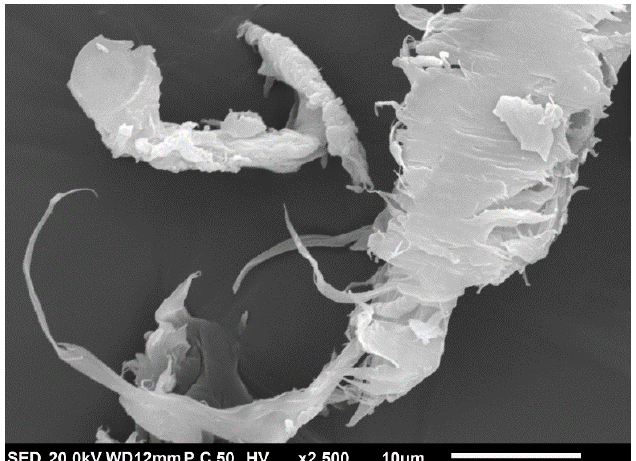
Figure 6. SEM image showing the surface of the wood